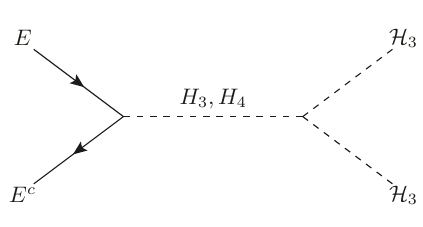
Figure 13 . Conversion between fermion and scalar dark matter components.